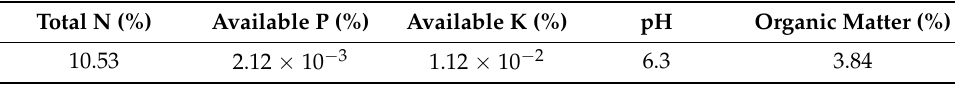
Table 1. Soil chemical properties of the experimental